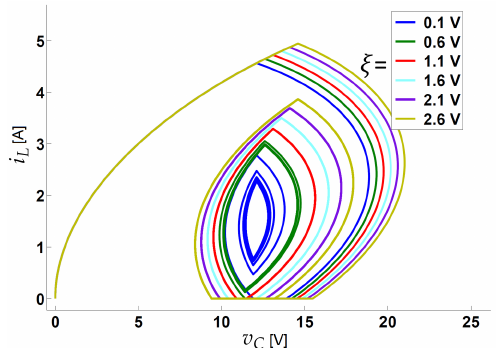
Figure 16. Phase portrait varying the hysteresis control parameter ξ . Increasing parameter ξ a Grazing bifurcation appears to transform the CCM 1 T -periodic orbit into a 1 T -periodic orbit in DCM with i L ≥